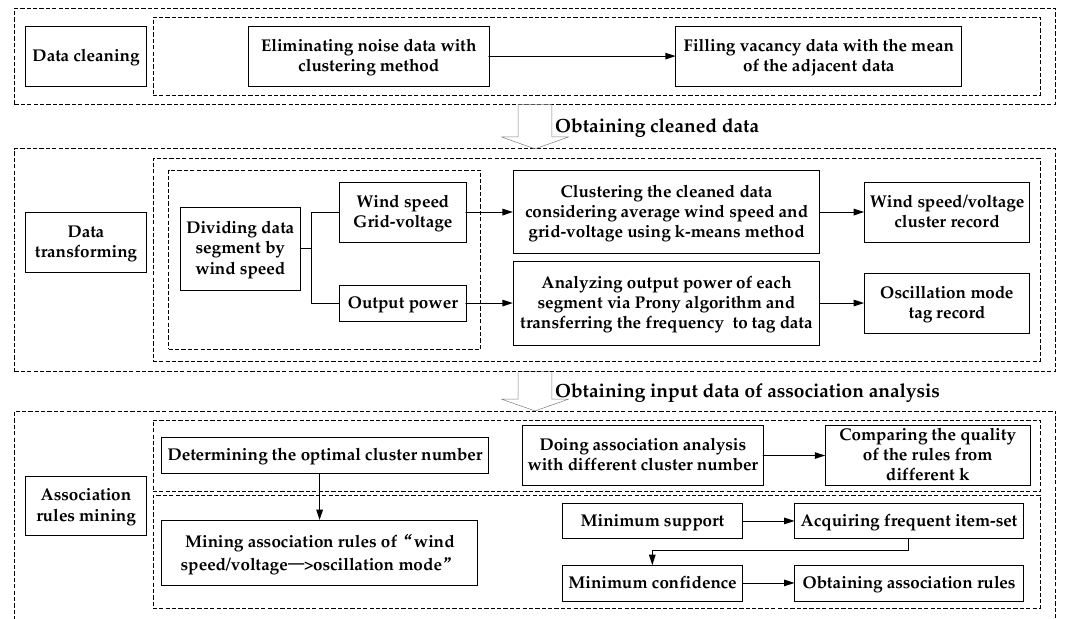
Figure 5. Correlation Analysis Modeling Process.